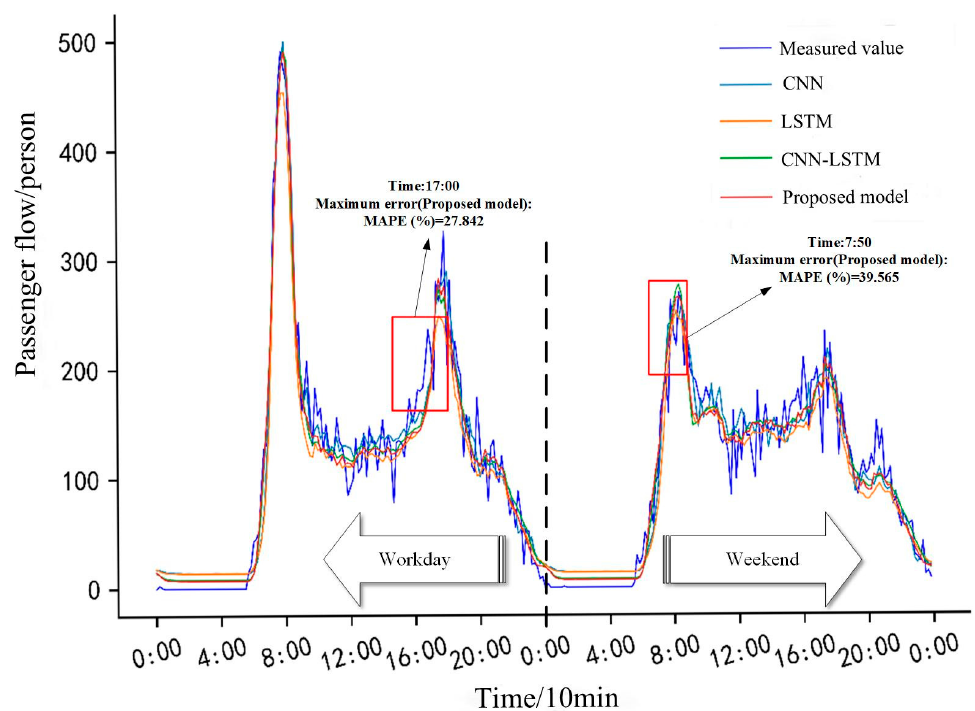
Figure 9. Comparison of passenger flow prediction between models (weekday and rest day at Linping